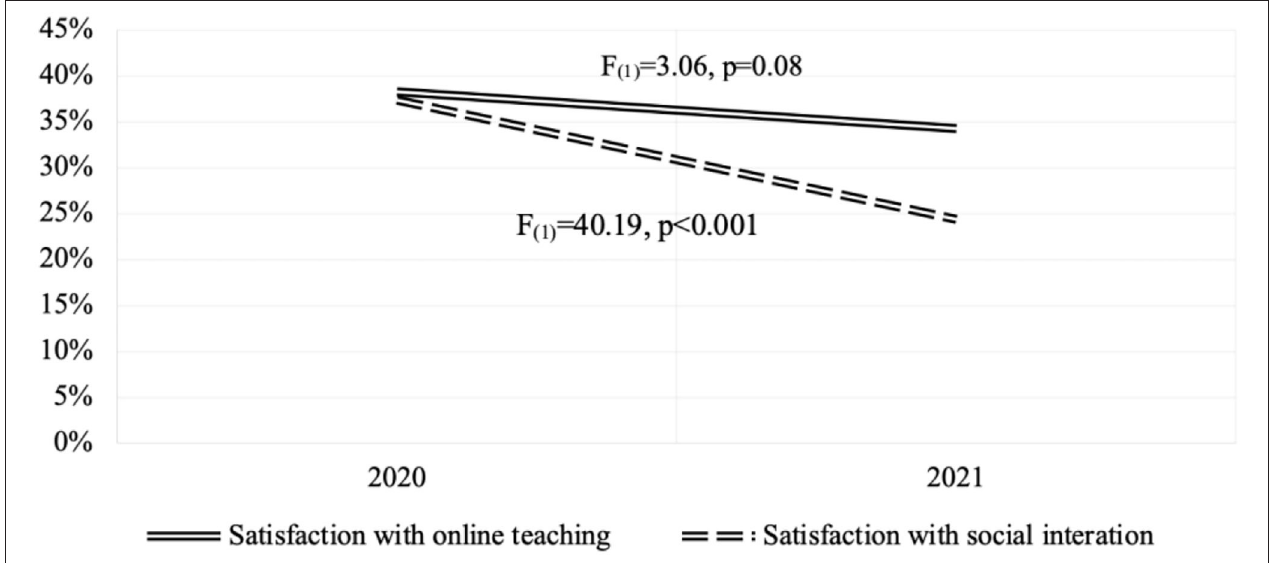
FIGURE 1 | Evolution of satisfaction with online teaching and social interaction between 2020 and 2021.